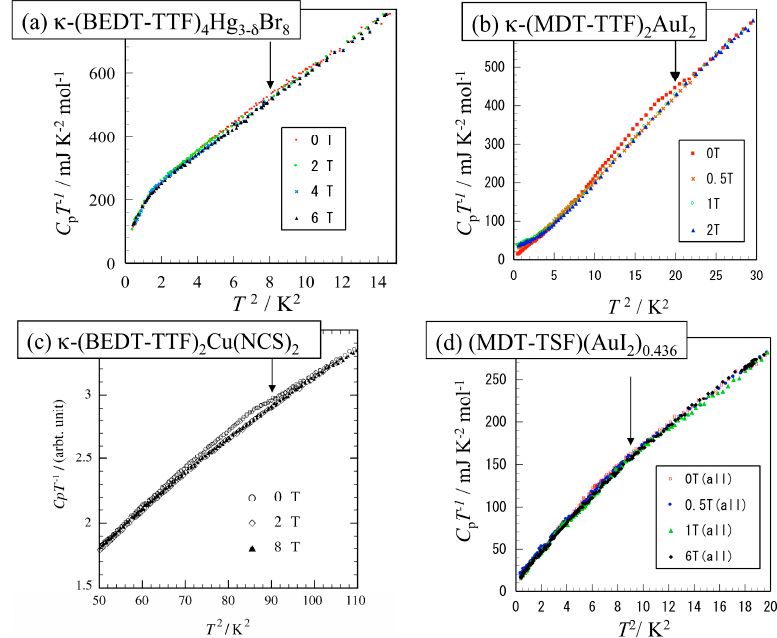
Figure 4. C p T − 1 vs. T 2 plot of superconductive compounds ( a ) κ -(BEDT-TTF) 4 Hg 1 − δ Br 8 (Refs. [47,48]); ( b ) κ -(MDT-TTF) 2 AuI 2 (Ref. [49]); ( c ) κ -(BEDT-TTF) 2 Cu(NCS) 2 (Refs. [49,50]); and ( d ) (MDT-TSF)(AuI 2 ) 0.436 (Ref. [51]) obtained under 0 T and with magnetic fields.